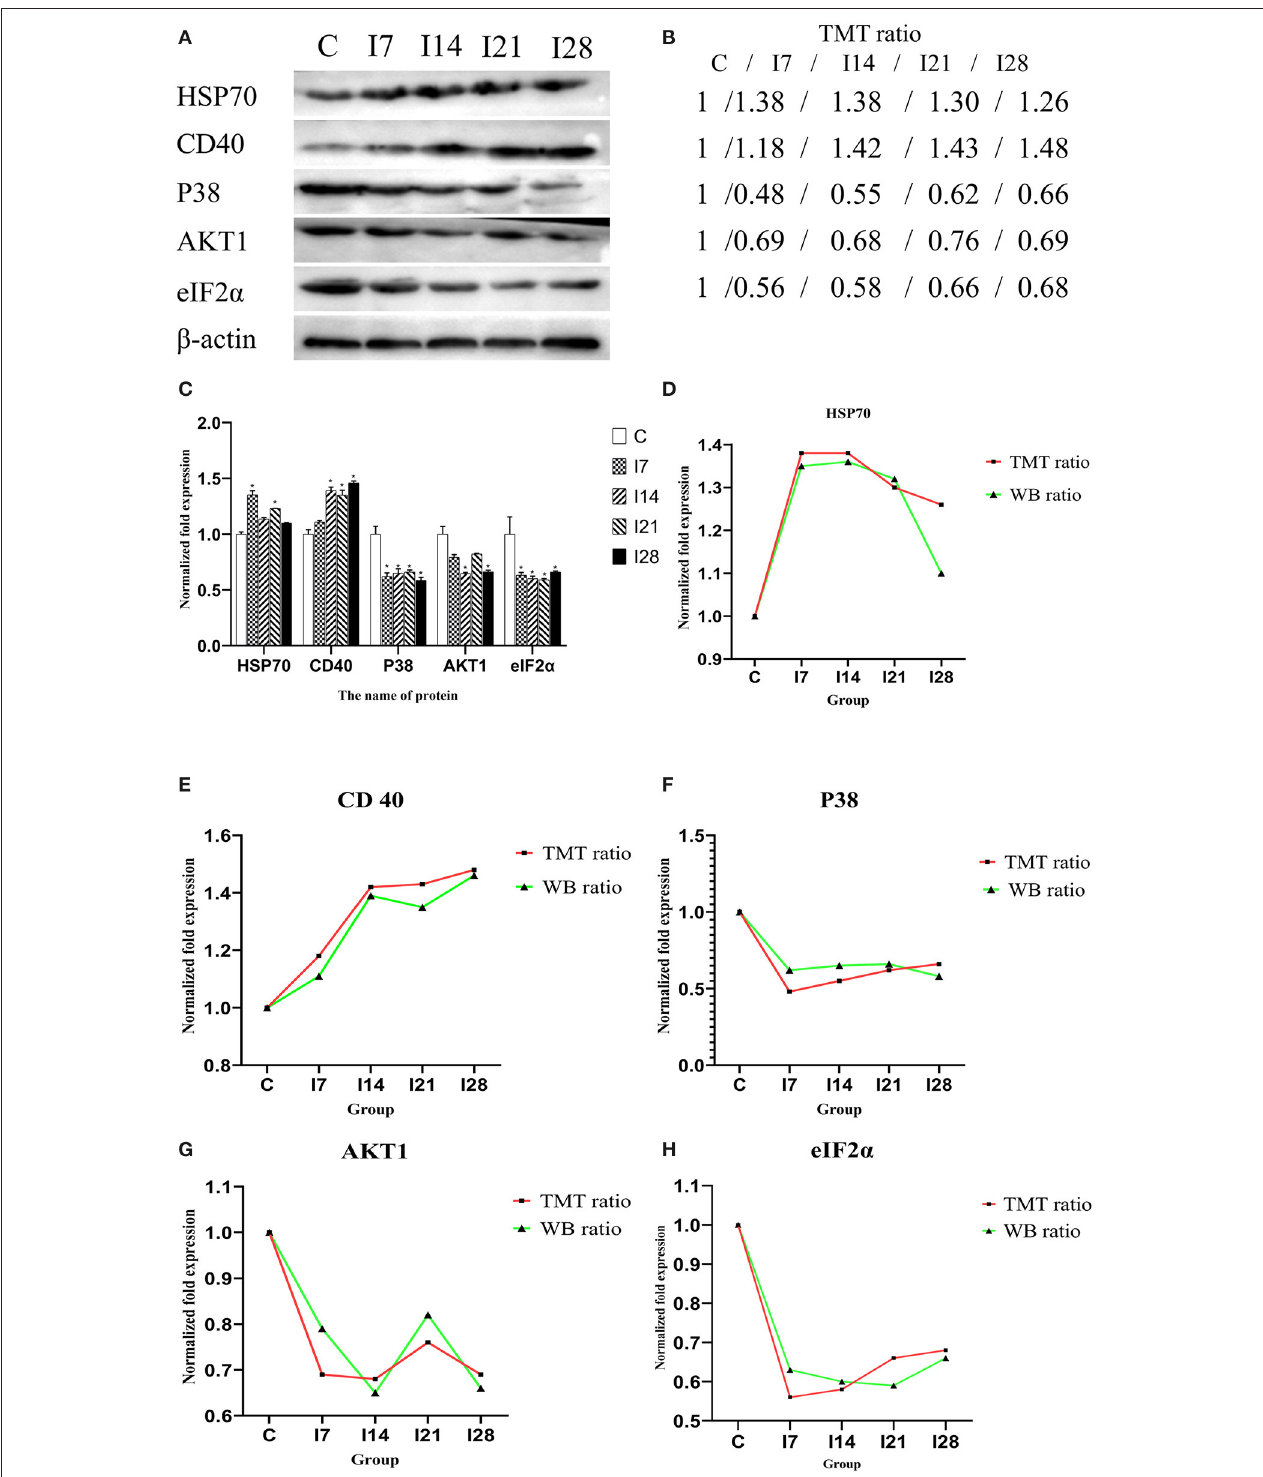
FIGURE 6 | Verification of differentially expressed proteins by Western blotting. (A) Representative Western blotting images of HSP70, CD40, p38, AKT1, and eIF2 α . (B) Tandem mass tag (TMT) ratios (C/I7/I14/I21/I28). (C) Western blotting quantitative analysis on the change of protein expression of HSP70, CD40, p38, AKT1, and eIF2 α . (D–H) The FC ratios between TMT and Western blotting (WB) data of HSP70, CD40, p38, AKT1, and eIF2 α .The expression trends of proteins identified by WB analysis-matched proteomics data. * P < 0.05 indicates a significant difference compared with the control group.